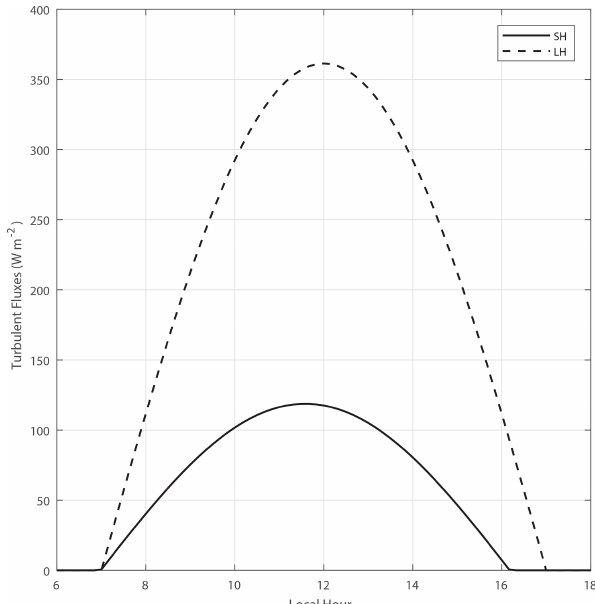
Figure 1. Prescribed surface turbulent fluxes of all DALES sim- ulations performed in this study. SH and LH are the sensible and latent heat fluxes, respectively. The Bowen ratio SH / LH is mostly between 0.1 and 0.4, consistent with the tropical rainforest environ-